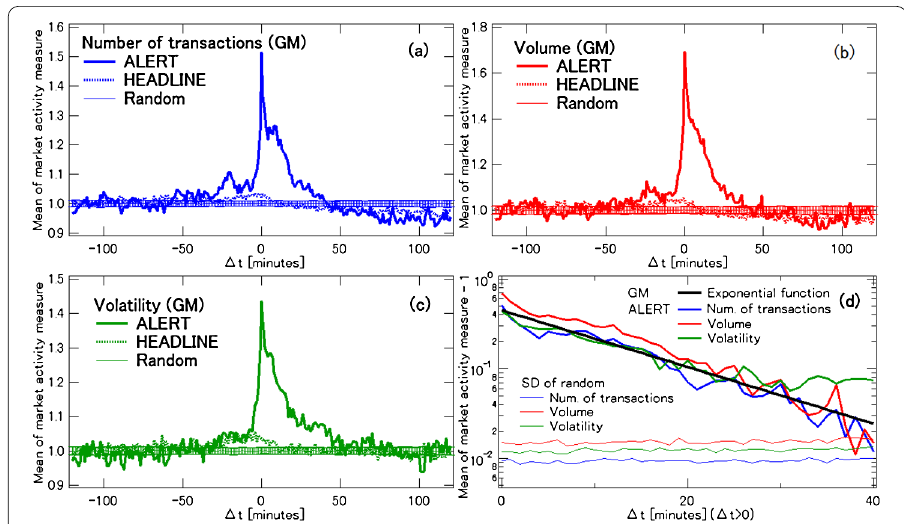
Figure 1 Market activity in GM stocks before and after an ALERT and a HEADLINE for GM are displayed. When (cid:2) t = 0, news articles with the keyword ‘GM.N’ are displayed on the RTRS electronic trading platform. ( a ), ( b ), and ( c ) show the normalized number of transactions, (cid:3) N ( (cid:2) t ) (cid:4) , the normalized volume, (cid:3) V ( (cid:2) t ) (cid:4) , and the normalized volatility, (cid:3) Vol ( (cid:2) t ) (cid:4) . ( d ) is a semi-logarithmic figure, where the solid and dashed lines respectively represent the market response to an ALERT and a HEADLINE news item. The black line in ( d ) is a reference line (= 0.45exp(–0.073 (cid:2) t ) + 1). The error bars shown in ( a ), ( b ), and ( c ) are for ALERTs and are calculated using randomized data (i.e., the timing of the arrival of news is randomized). The error bars for HEADLINEs are not shown in ( a ), ( b ), and ( c ) to make the figures easier to read. For ( d ), only the upper bound of the error bar is